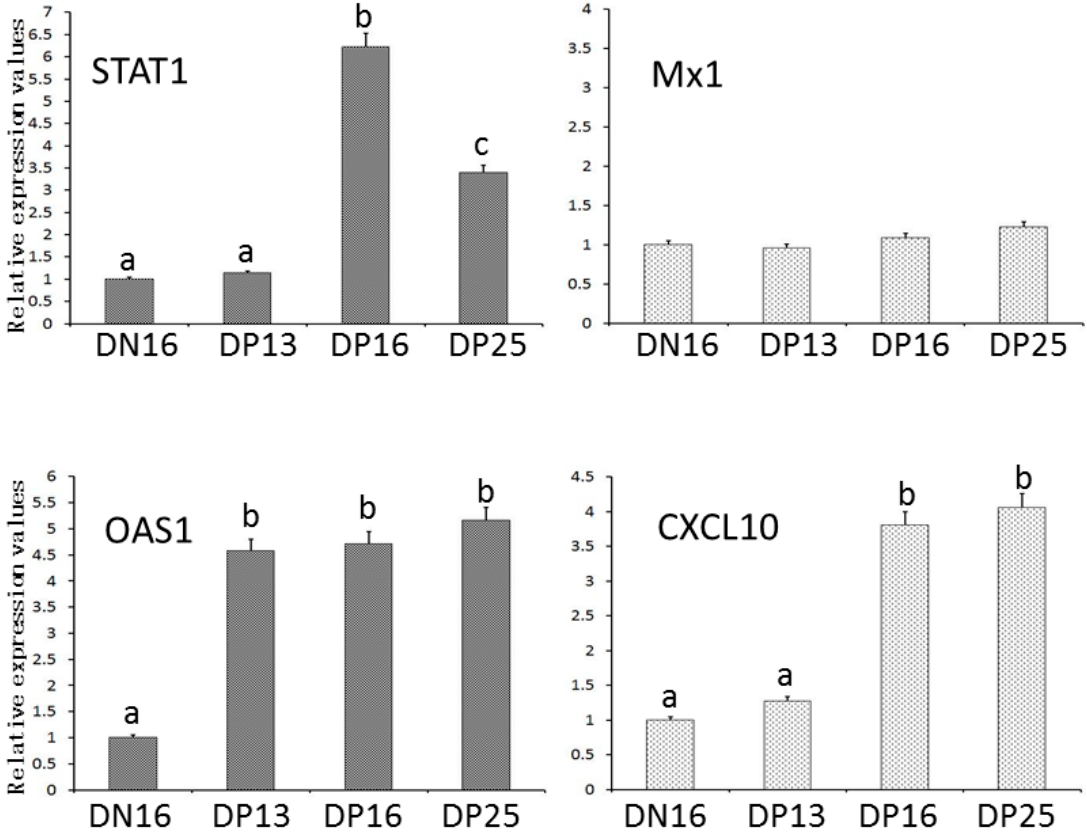
Figure 1. Relative expression values of STAT1 , OAS1 , MX1 and CXCL10 mRNA in ovine spleens measured by real-time quantitative PCR. Note: DN16 = Day 16 of the estrous cycle; DP13 = Day 13 of pregnancy; DP16 = Day 16 of pregnancy; DP25 = Day 25 of pregnancy. Significant differences ( p < 0.05) are indicated by different letters within same color column.